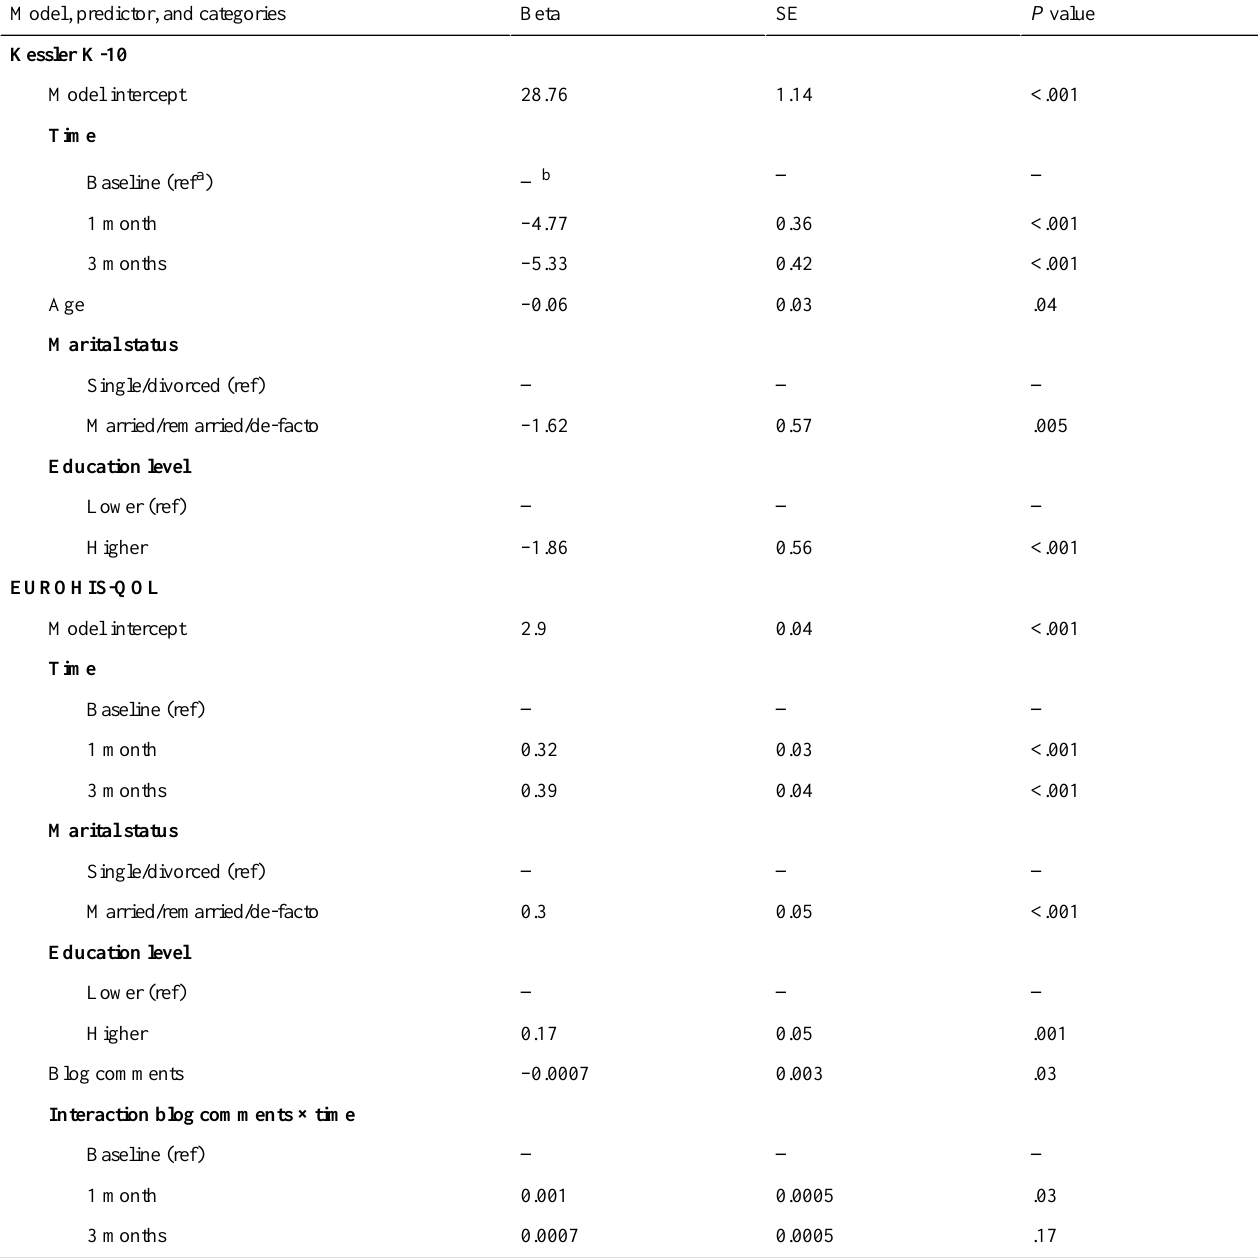
P valueSEBetaModel, predictor, and categories